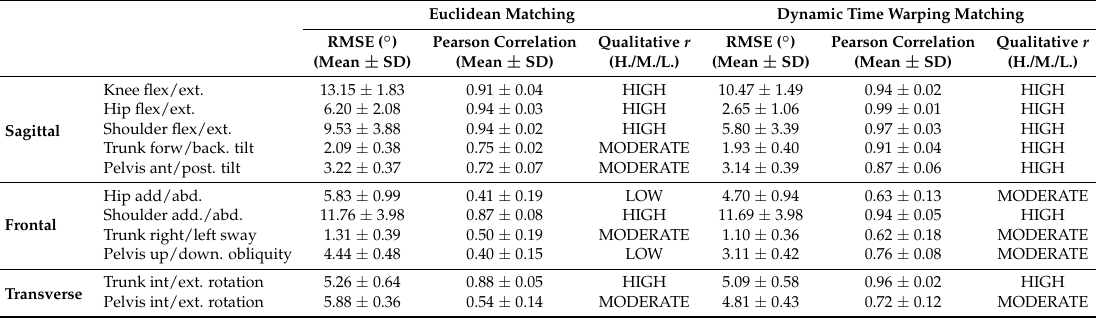
Table 2. The accuracy of the Kinect sensor for Euclidean matching and DTW matching. The RMSE and also the Pearson correlation ( r ) were averaged for all iterations performed during data